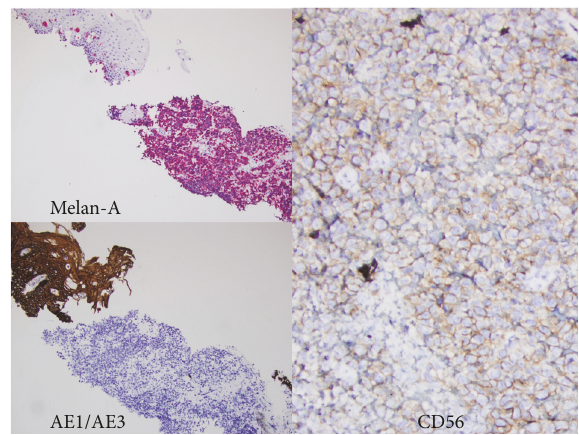
Figure 3: The malignant cells are positive for Melan-A and CD56 with a negative cytokeratin